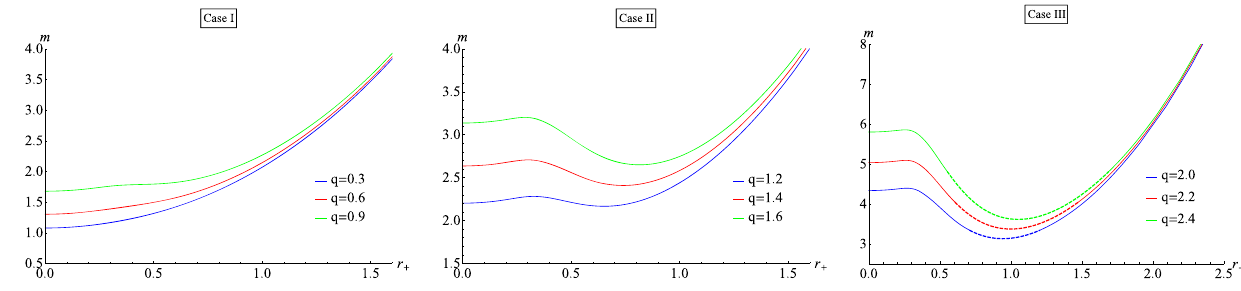
Fig. 2 The mass function given at Eq. (34) is plotted in terms of the horizon radius, at α = 0 . 5, l = 5 and k = 0 . 4